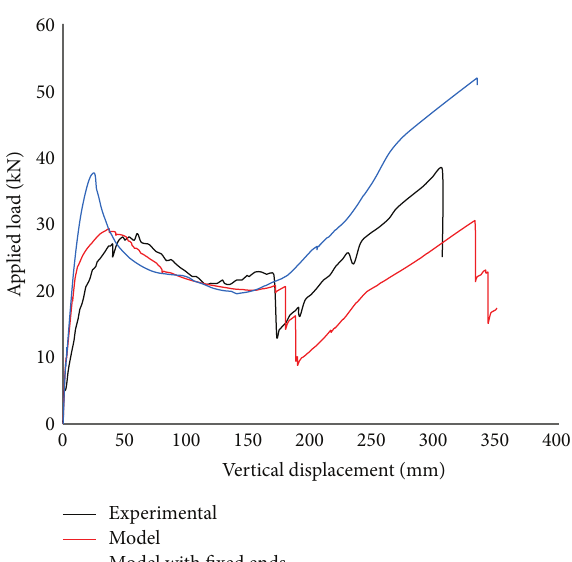
Figure 18: Numerical and experimental load-deflection results of the scaled specimen.